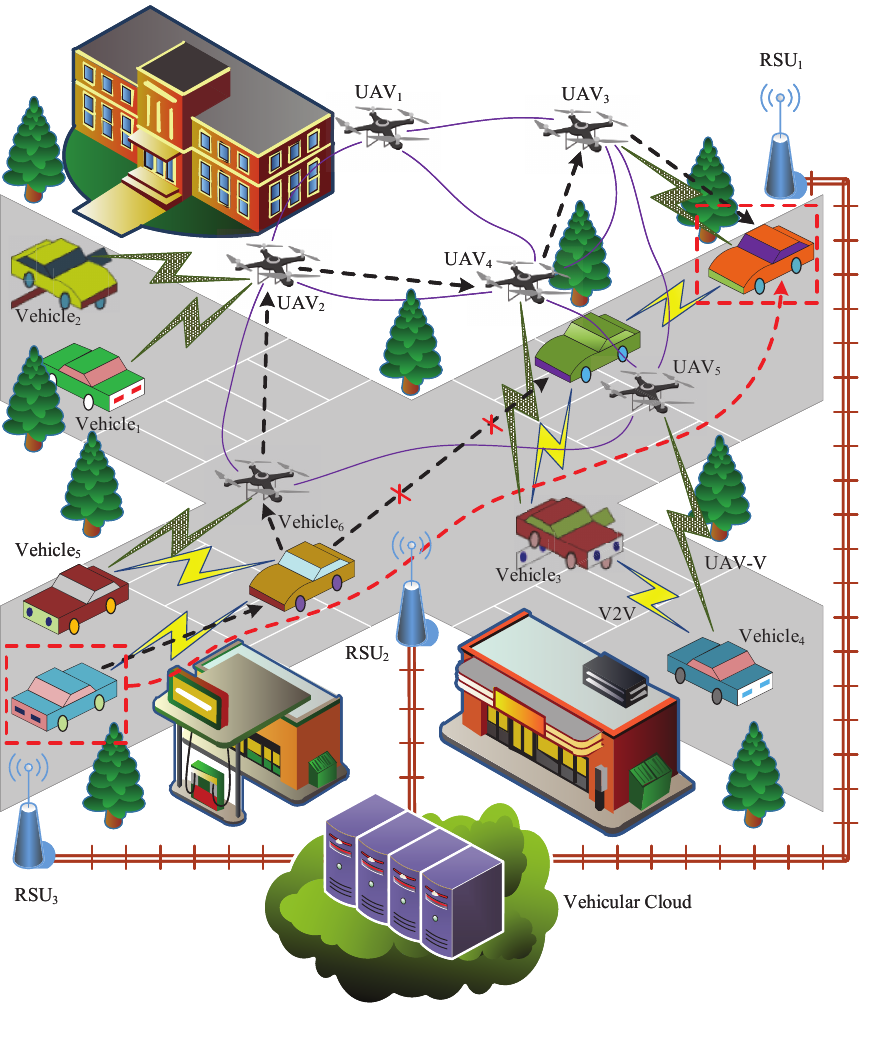
Figure 1. UAV-Assisted VANET System Model. The vehicles communicates with each other via V2V communication as shown with yellow lightening flash. The UAV-V communications are shown with ribbed lightening flash. The Vehicular Cloud maintains direct link with all RSUs. The neighboring UAVs associate with each other as shown with purple curve. The dotted red arrow indicates the remote V2V data delivery, which is conducted through the UAV-assisted VANET (dotted black arrow). In this way, the environmental obstructions can be